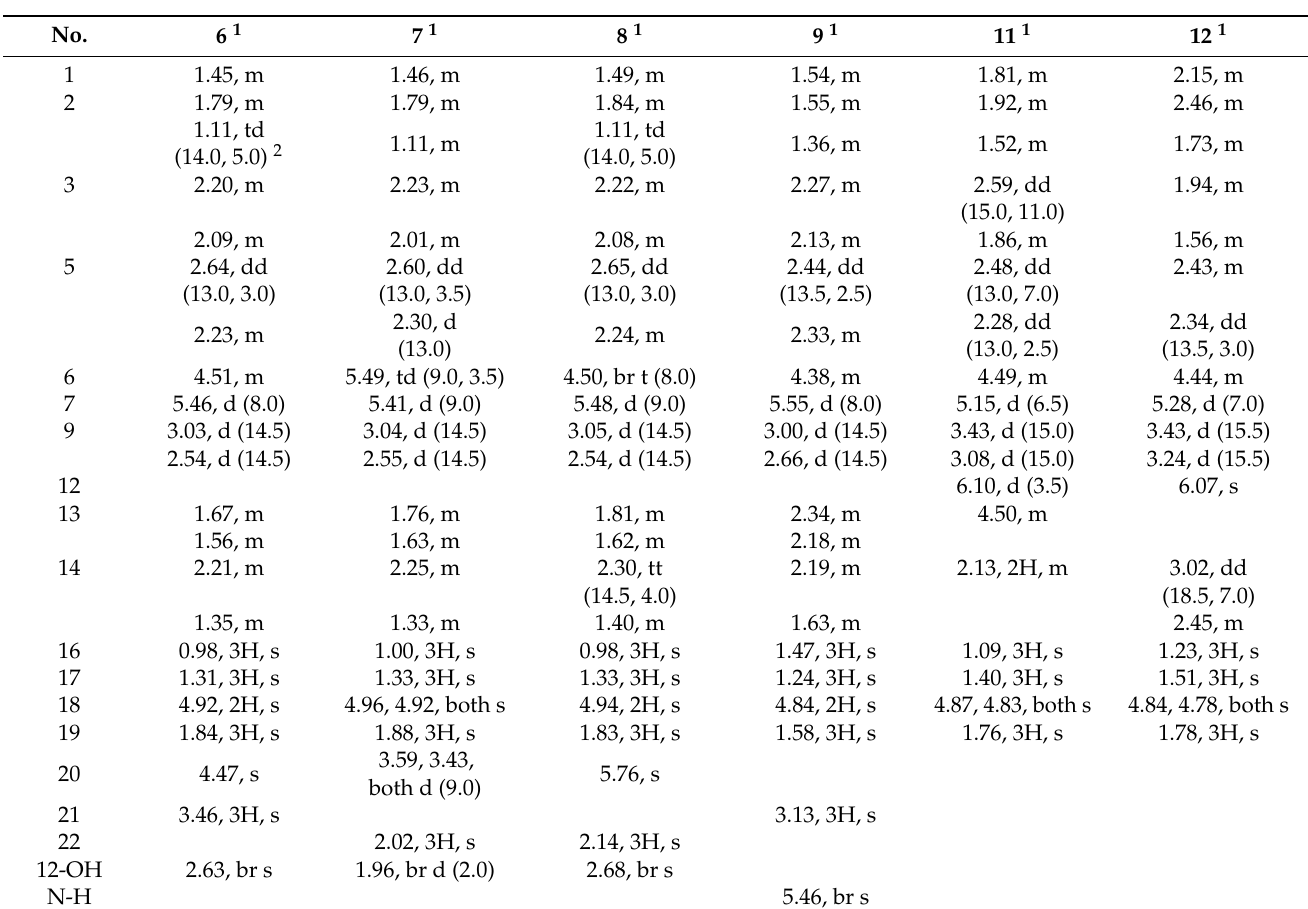
Table 3. 1 H NMR spectroscopic data of compounds 6 – 9 , 11 , and 12